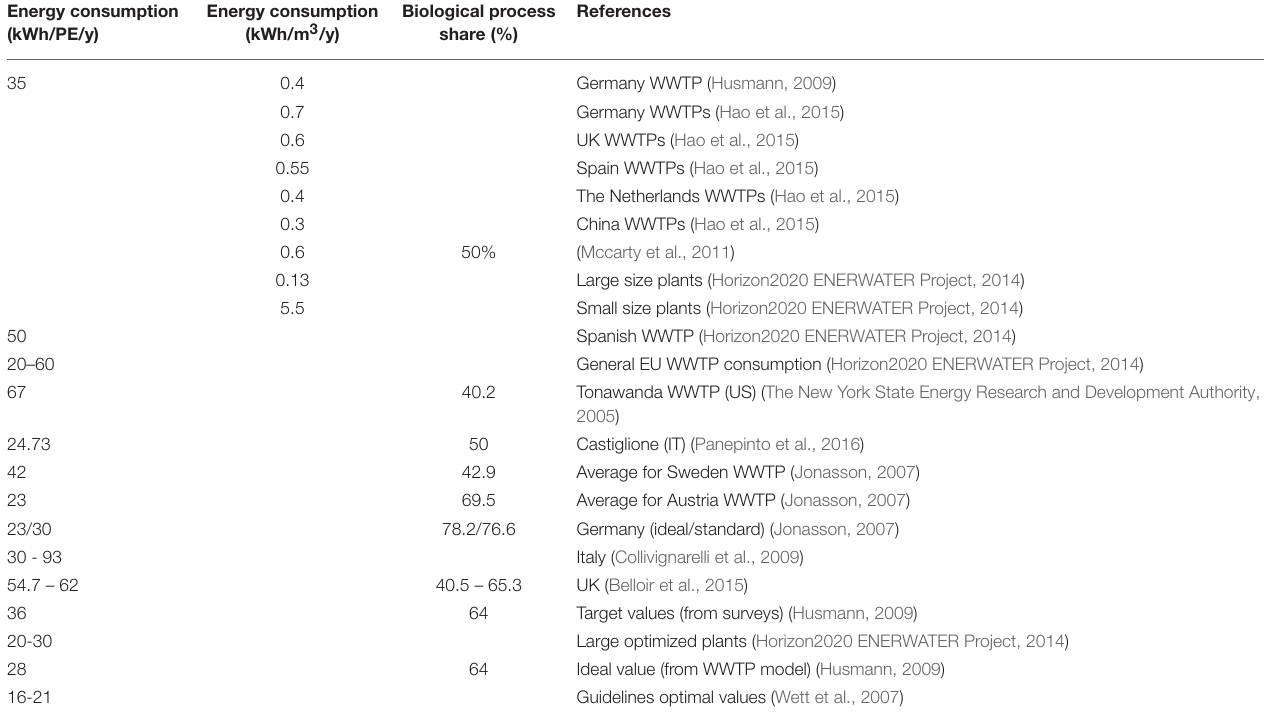
TABLE 1 | Comparison of specific energy consumption data and biological process influence for different sources. Energy consumption